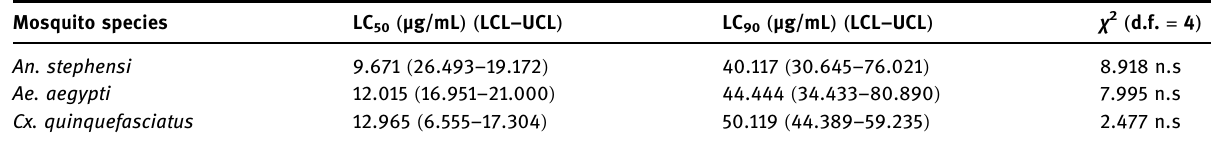
Table 4: Adulticidal toxicity of Cs - AgNPs against An. stephensi, Ae. aegypti , and Cx. quinquefasciatus Mosquito species